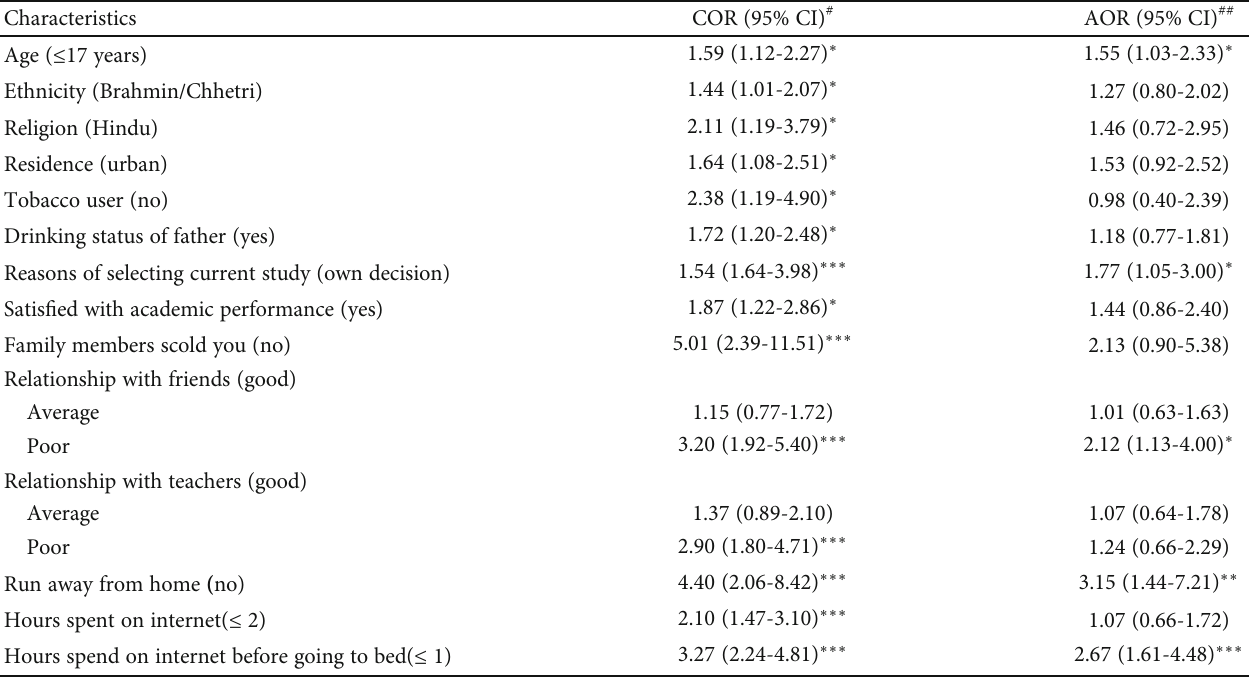
Table 3: Multivariate analysis of factors associated with sleep